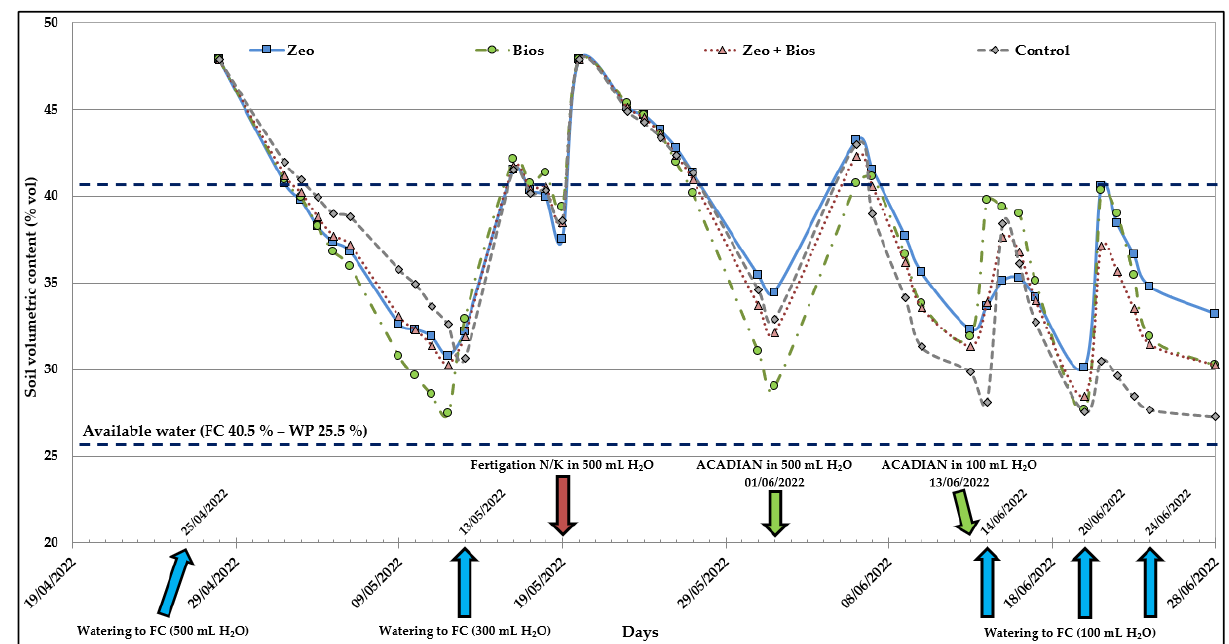
Figure 1. Soil water content trend measured by watermark probes during spinach growing cycle treated with coal fly ash zeolite (Zeo), A. nodosum -based biostimulant (Bios), and zeolite plus A. nodosum -based biostimulant (Zeo + Bios). Values are mean ( n = 3). Table 2. Effects of treatments on some morphological and physiological traits of spinach and on soil volumetric water